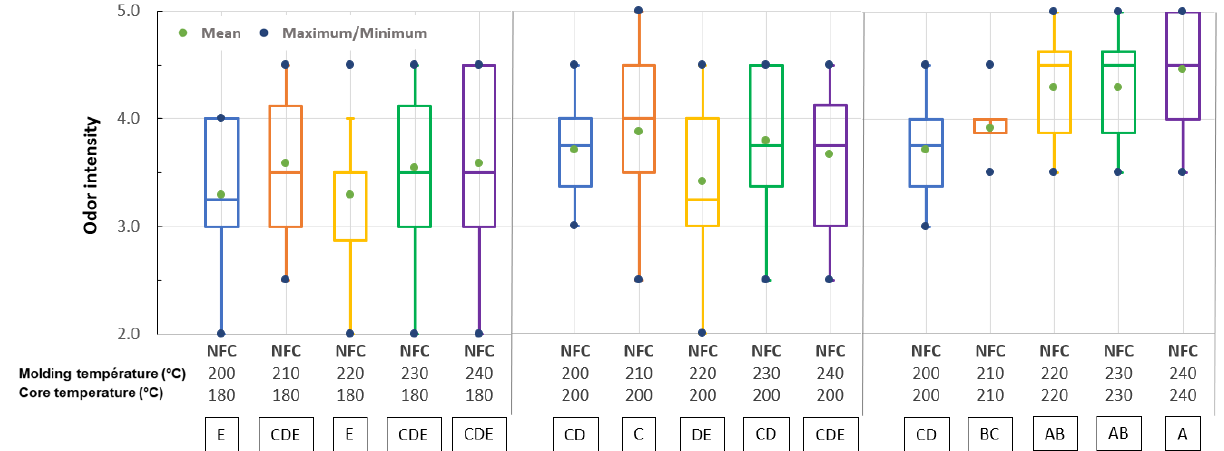
Figure 3. Box-plots of odor intensity coming from the NFC according to the molding temperature and the core temperature of the nonwoven in situ during the compression molding process. Letters A, B, C, D and E on the box-plot diagrams are the result of ANOVA analyses (Fisher’s test). NB: Two means with at least one letter in common are not significantly different/two means with no letter in common are significantly different.